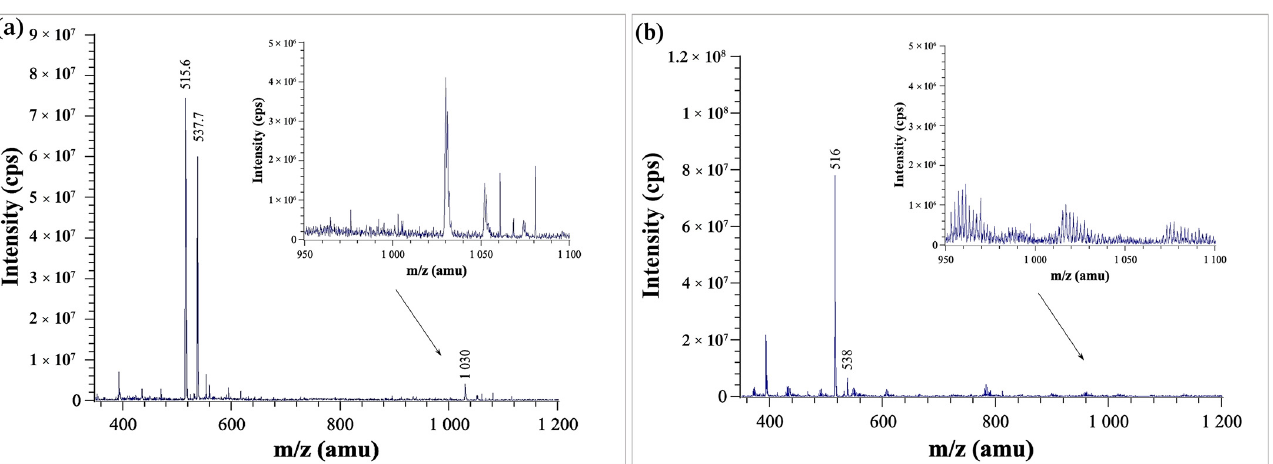
Figure 7. Dimerization of zwitterionic telmisartan along with the corresponding reaction Gibbs free energy ( Δ r G ) and enthalpy ( Δ r H ) values in kcal/mol. The structures have been computed at the M06- 2X/6-31G(d) level of theory. The effect of water was mimicked by using the CPCM implicit solvent model. Orange ellipsoids indicate the protonation sites.